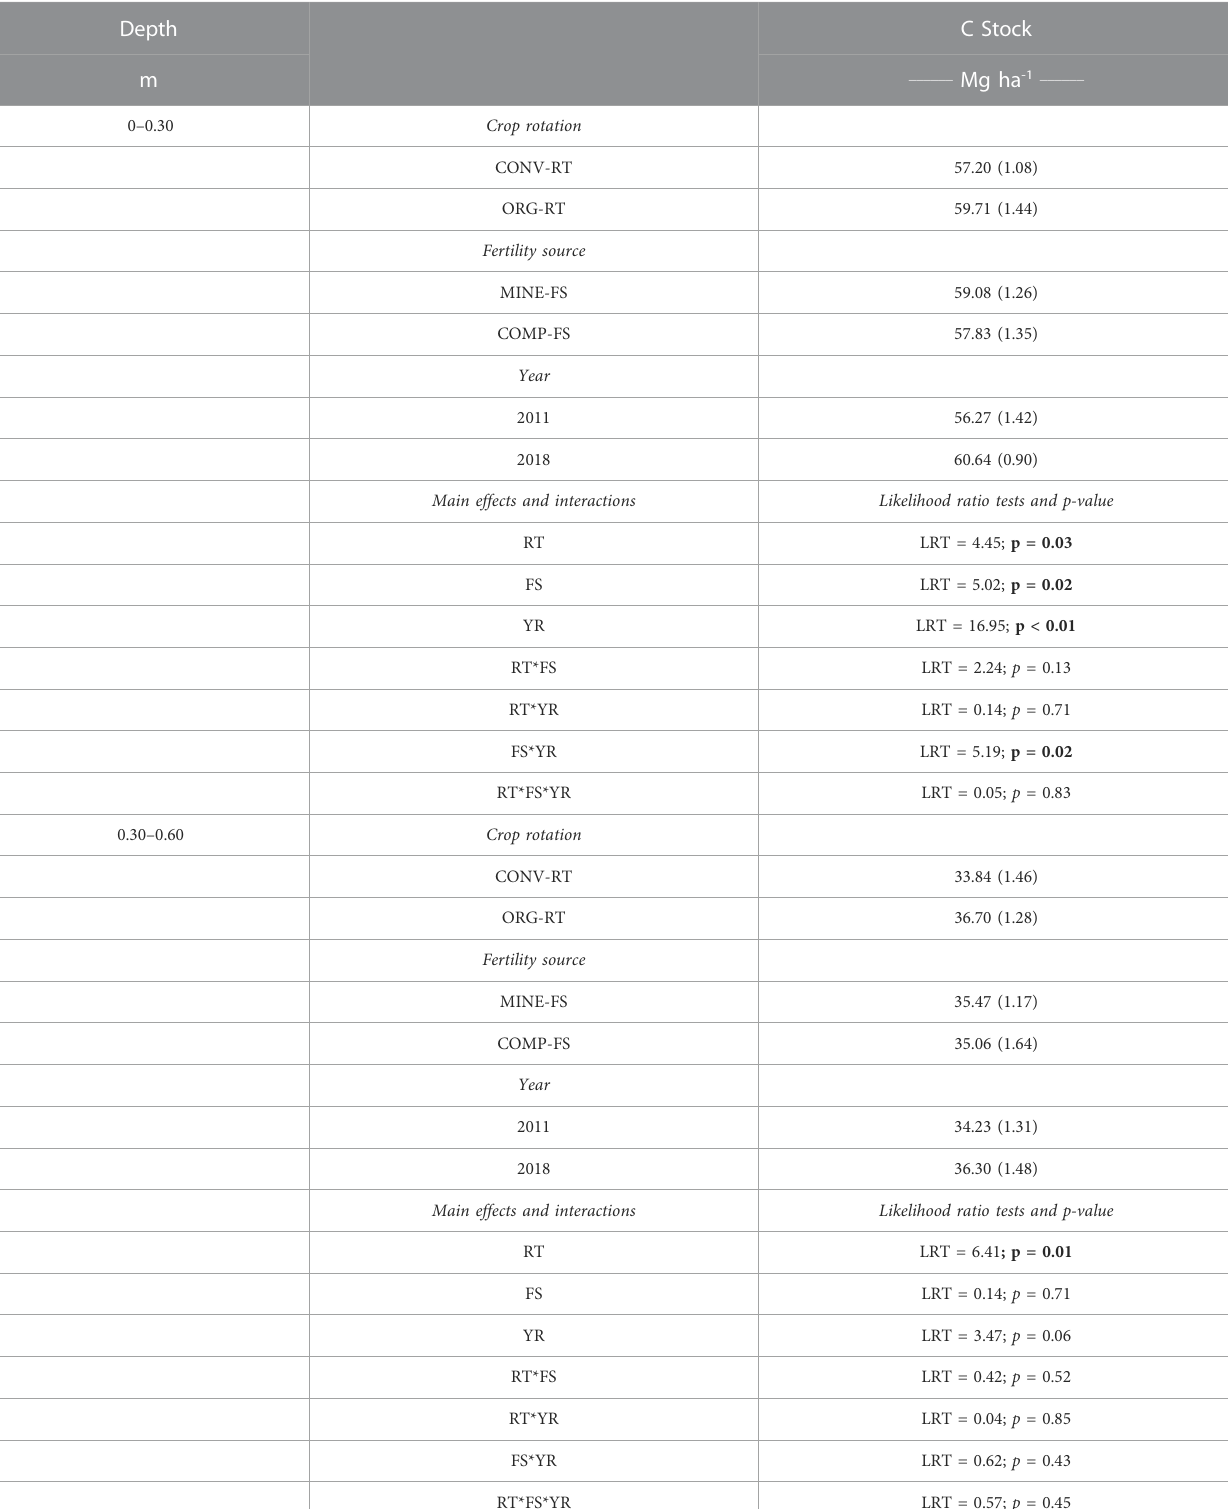
TABLE 2 Main effect means for crop rotation (RT) (conventional-CONV-RT vs. organic-ORG-RT), fertility sources (FS) (mineral-MINE-FS vs. compost-COMP-FS), and years of sampling (YR) (2011 and 2018). Signi fi cant of the main effects and their interactions on soil organic C stocks (SOC stock) at 0 – 0.30 and 0.30 – 0.60 m soil depth